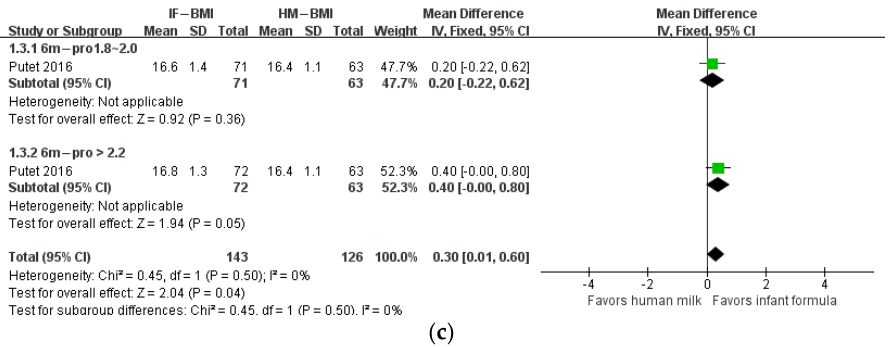
Figure 6. Forest plot of the effects of protein content of infant formula on the weight gain, height gain, and BMI of infants at 6 months of age. ( a ) The effects on weight gain. ( b ) The effects on height gain. ( c ) The effects on BMI.